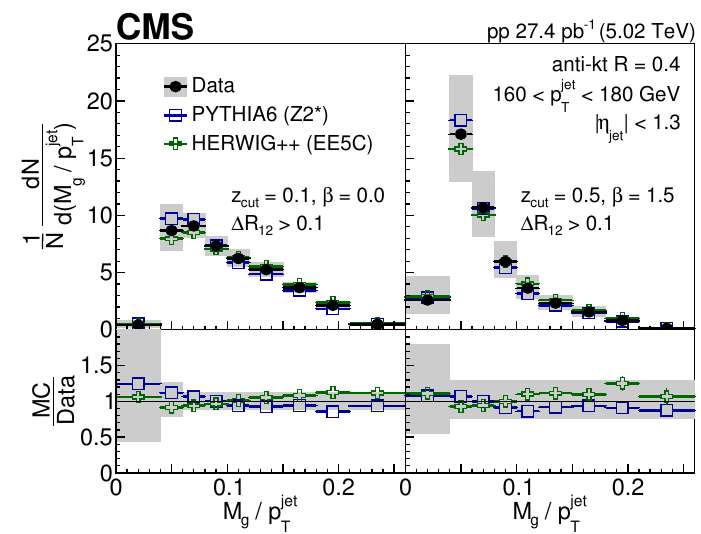
Figure 2 . The spectra of M g =p jet for pp events with 160 < p jet < 180 GeV using (0 : 1 ; 0 : 0) SD T T setting (left panels) and (0 : 5 ; 1 : 5) SD setting (right panels). Results are compared to pythia and herwig++ event generators. The ratio of simulation to data is also shown. The heights of the gray boxes indicate systematic uncertainties. Statistical uncertainties are less than the marker